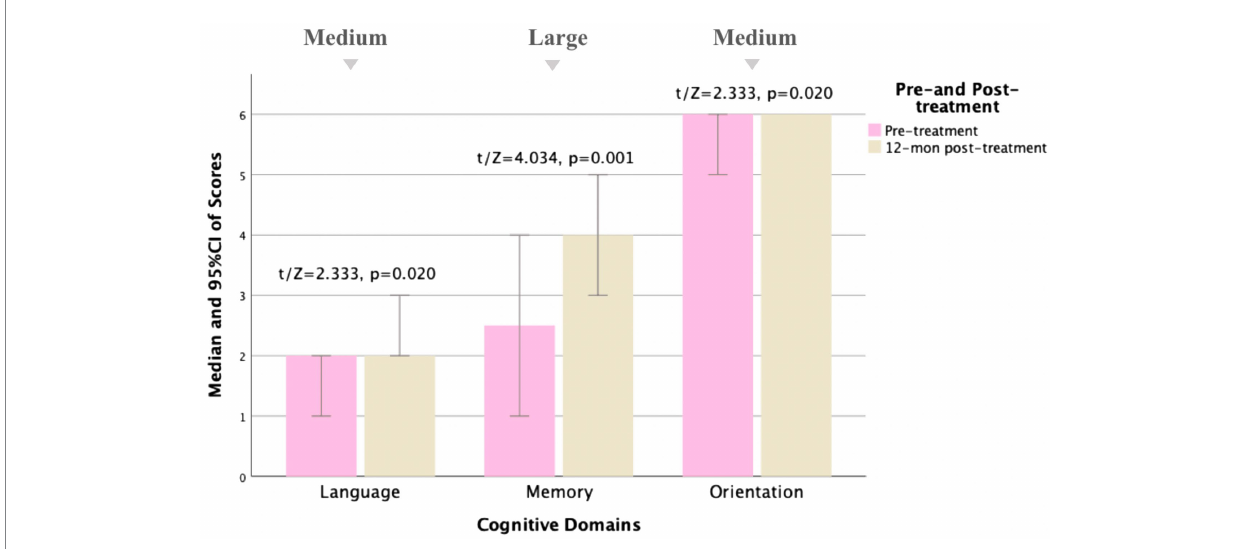
FIGURE 4 Comparison of MoCA subscale scores pre- and 12 months post-treatment for MD patients ( N = 18). Compared to pre-treatment, MoCA subscale scores improved mainly in language, memory, and orientation aspects ( t /Z = 2.333, 4.034, and 2.333, and p < 0.05) at 12 months post-treatment, especially in memory aspects ( p < 0.01). Small, medium, and large indicate clinically meaningful Cohen d effect sizes.